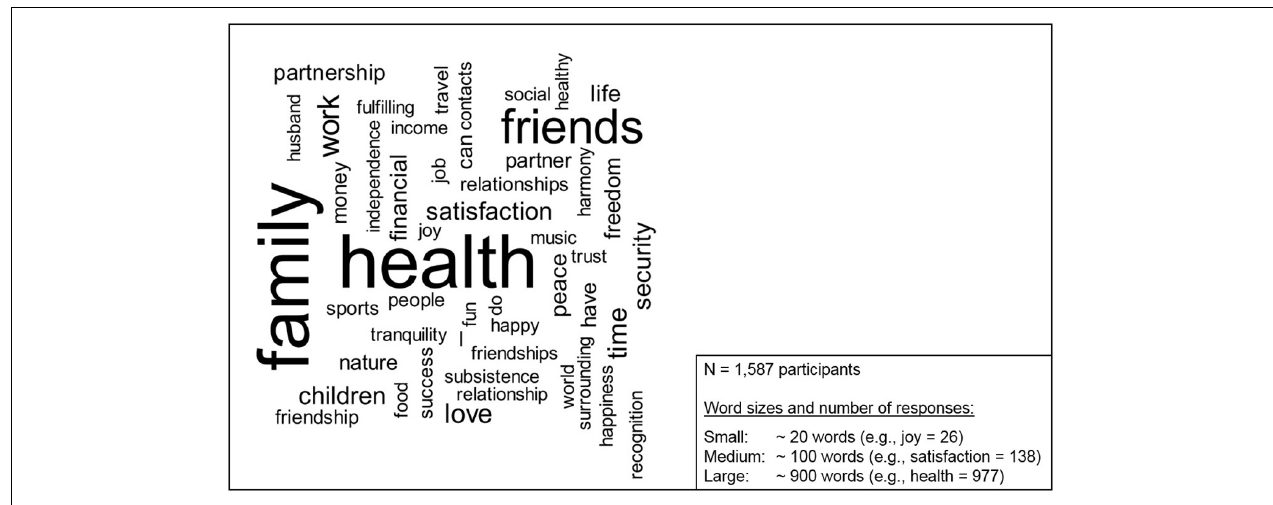
FIGURE 2 | Word cloud representing the distribution of responses from the overall study population. TABLE 2 | Distribution of responses across the main categories for the overall study population and according to different age groups.